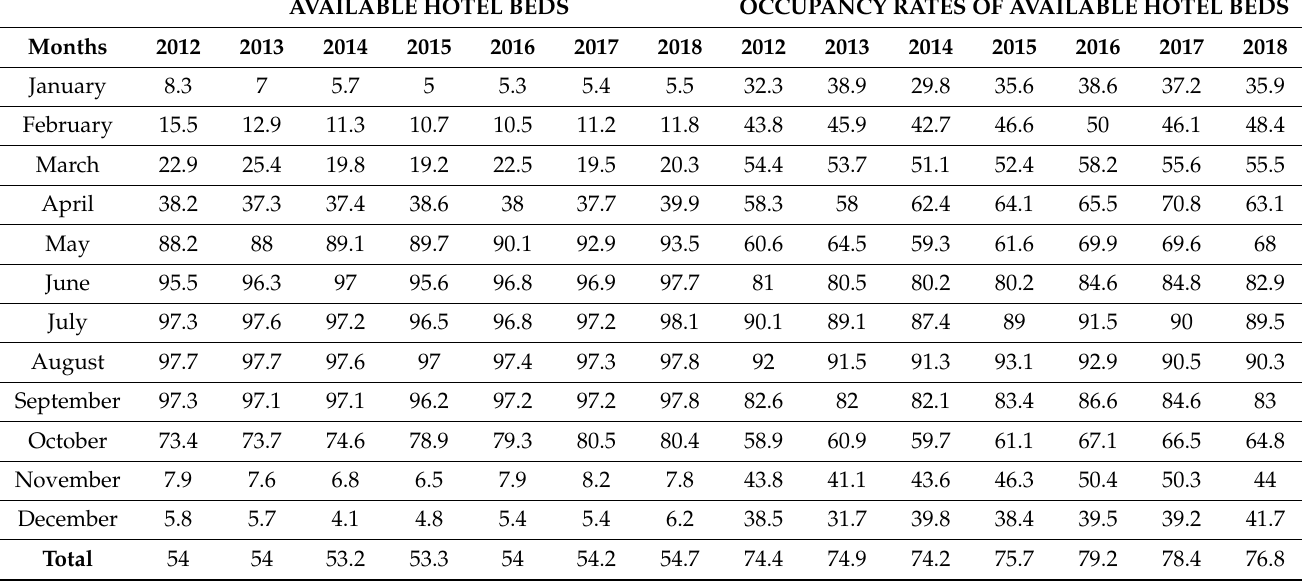
Table 7. Percentage of available hotel beds and occupancy rate of available hotel beds in the Balearic Islands broken down by months (2012–2018).